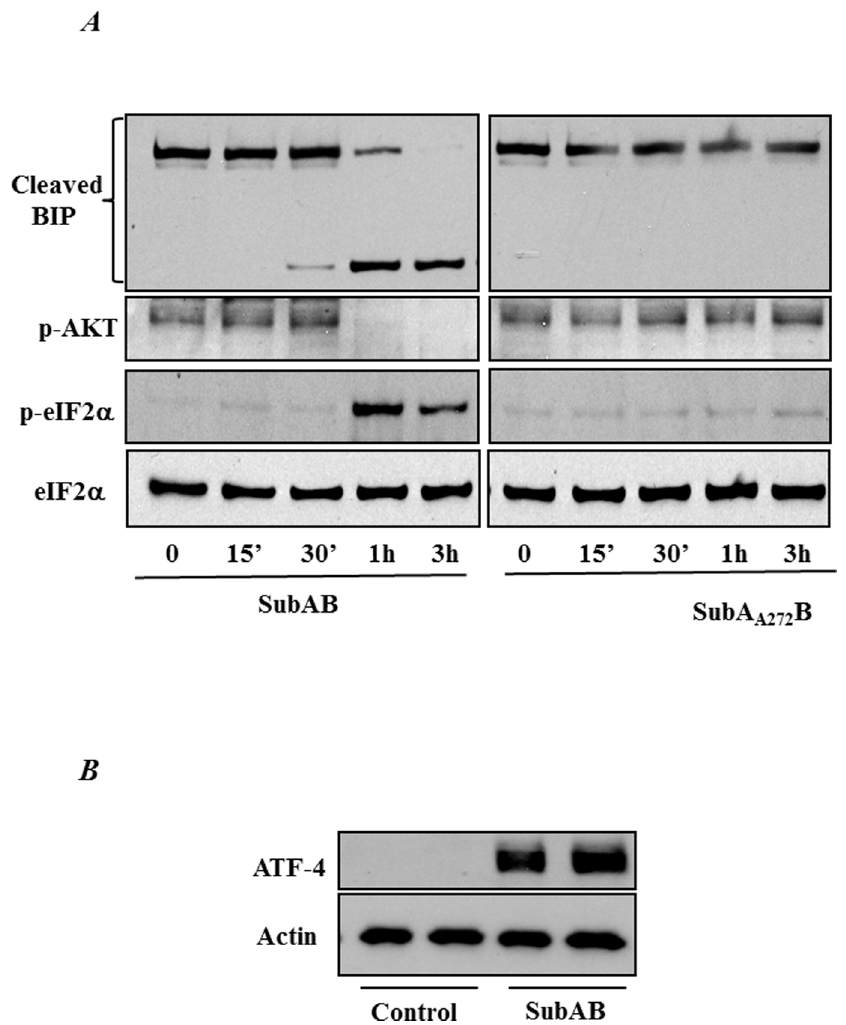
Figure 9. SubAB induces BiP cleavage and ER stress. ( A ) HPAEC were treated with 0.1 m g/ml of SubAB or mutant SubA A272 B for the indicated time points. Cell lysates were immunoblotted with an anti-phospho eIF2 a antibody and anti-phospho- AKT antibody to determine the induction of ER stress. The levels of total eIF2 a were used to monitor loading. BiP antibody was used to monitor the cleavage of BiP by SubAB. ( B ) HPAECs were treated with 0.1 m g SubAB for 3 hours and cell lysates were immunoblotted for ATF-4 antibody. Actin was used as a loading